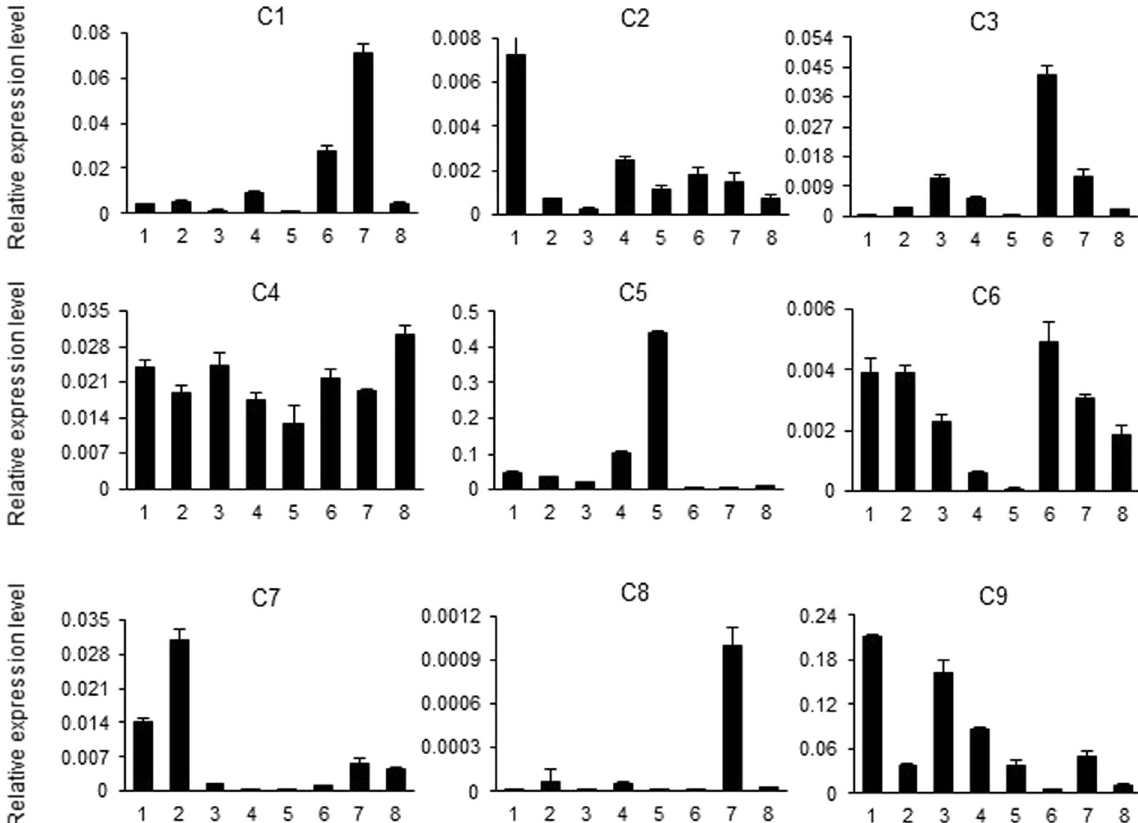
Figure 3. Expression patterns of nine candidate genes for salt-tolerance traits in different tissues and developmental stages. 1–8 indicate root, stem, leaf, petal, anther, 0 DPA ovule, 10 and 20 DPA fibers in TM-1, respectively. The error bars were calculated based on three biological replicates using standard deviation. The cotton histone3 (AF024716) gene was used as the reference